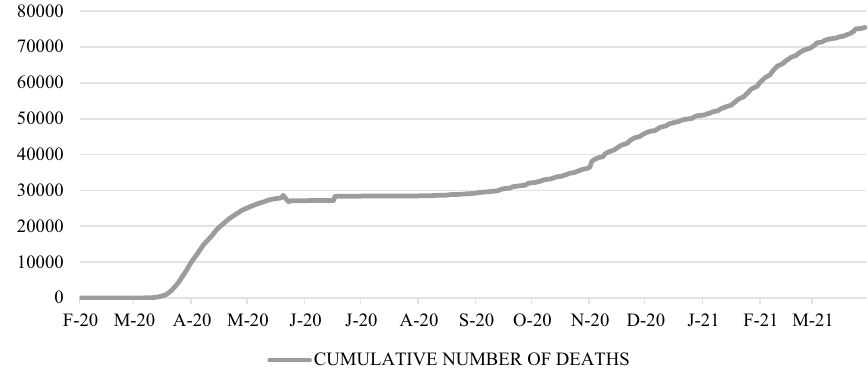
Fig. 1 Cumulative number of deaths from COVID‑19 (February/2020–April/2021). Source : National Centre